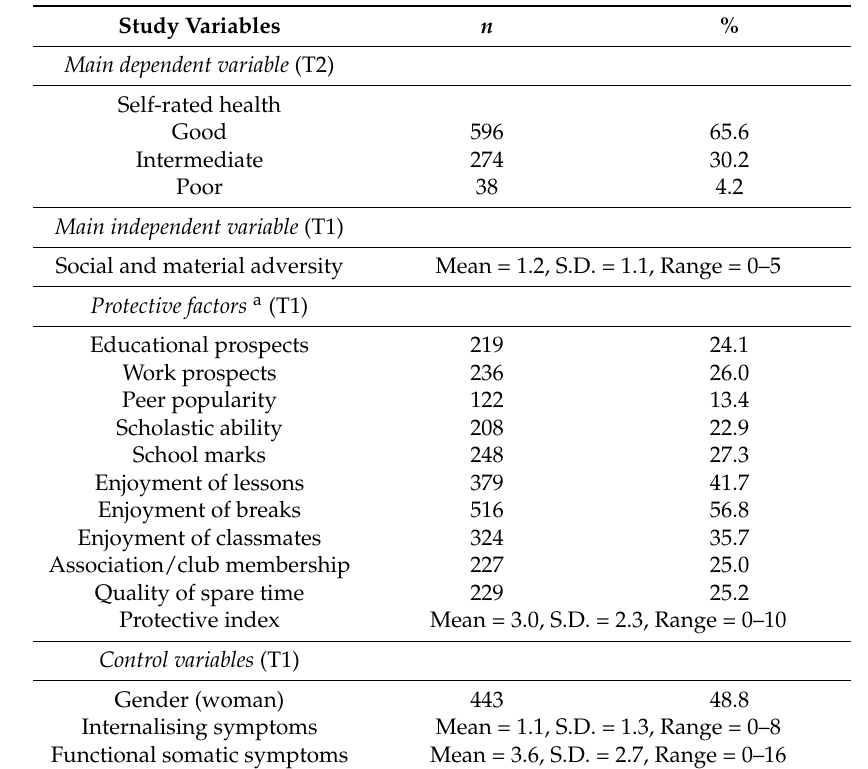
Table 1. Descriptive statistics for all study variables ( n =